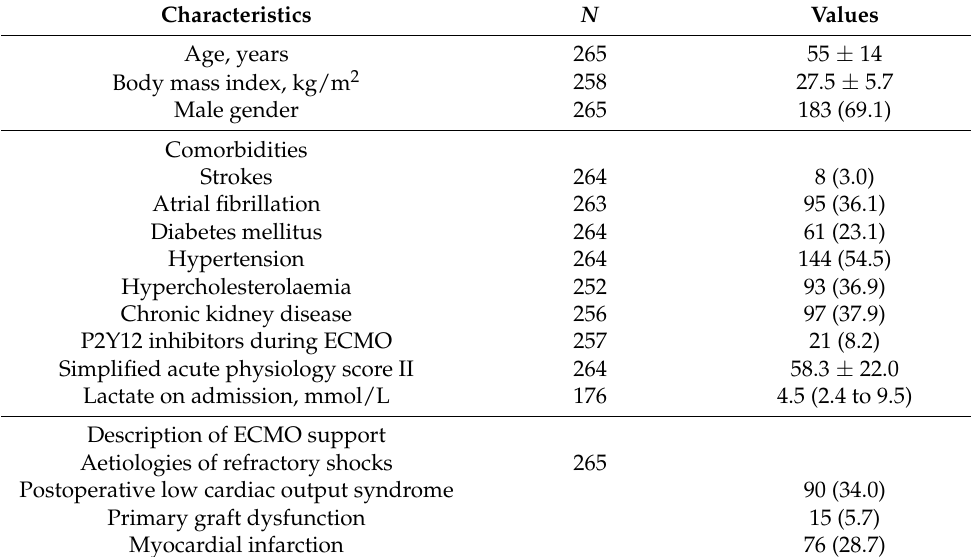
Table 1. Characteristics of the study population ( n =